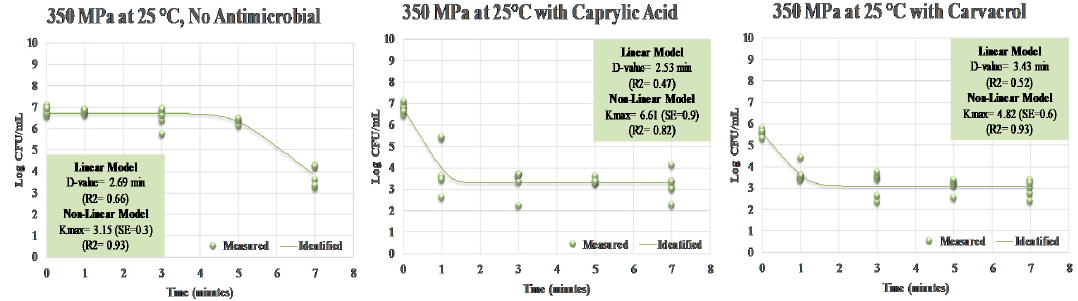
Figure 6. Linear and non-linear inactivation indices for S. aureus treated by hydrostatic pressure (350 MPa at 25 °C) in the presence of 0.5% ( v / v ) caprylic acid and 0.5% ( v / v ) carvacrol. Measured = Actual observations; Identified = Best-fitted non-linear